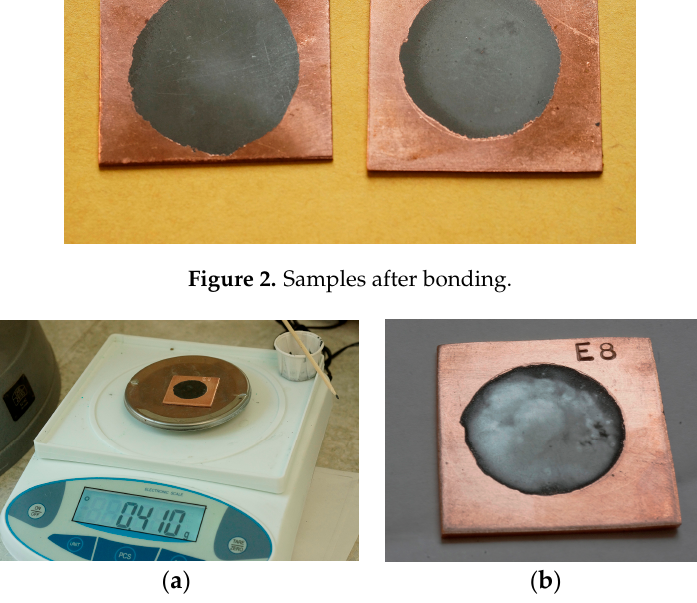
Figure 3. Application of the slurry: ( a ) Weighting the deposit ( b ) Sample coated, dried, and rolled.